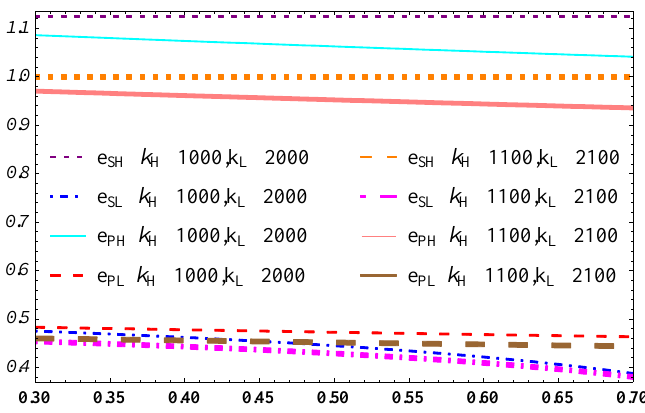
Figure 6. Influence of θ on the level of carbon reduction.